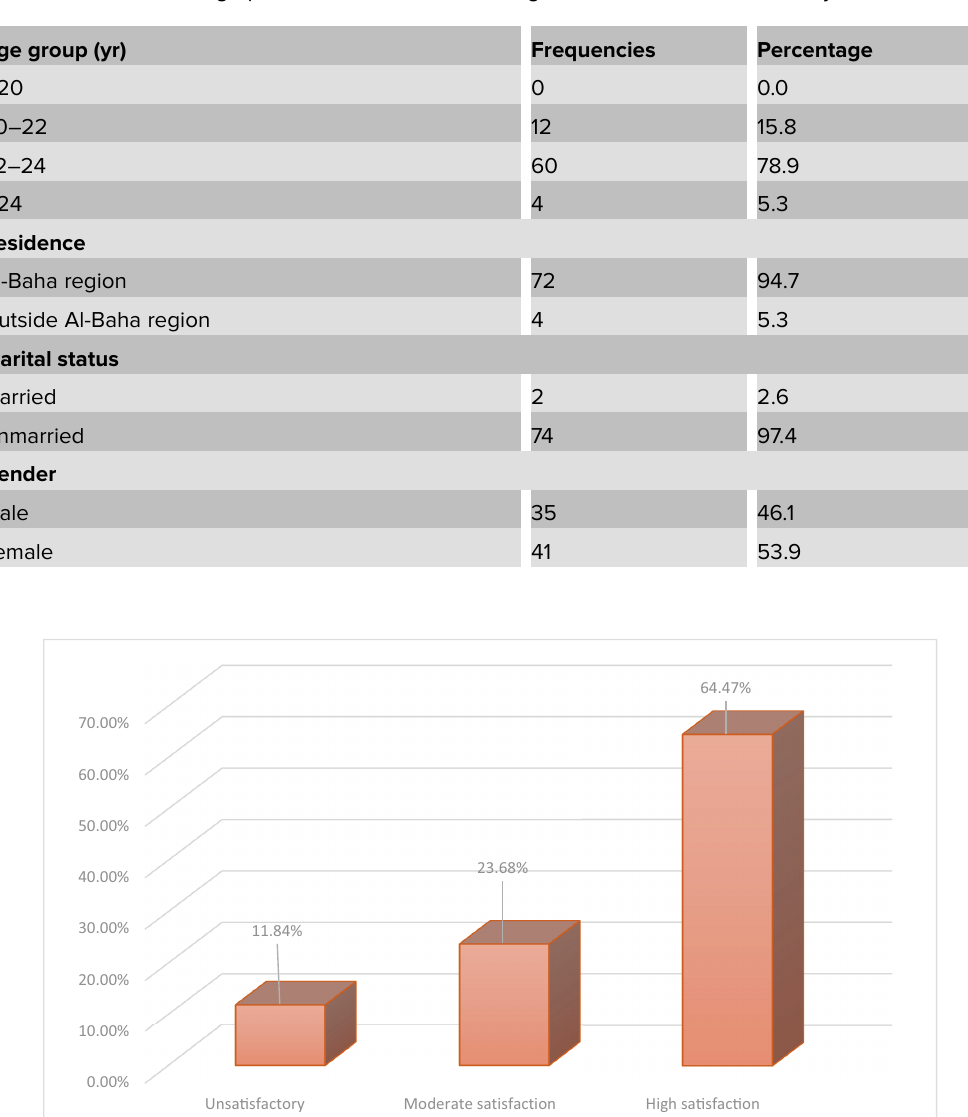
Table 1: Demographic characteristics of nursing students at Albaha University, n = 76.